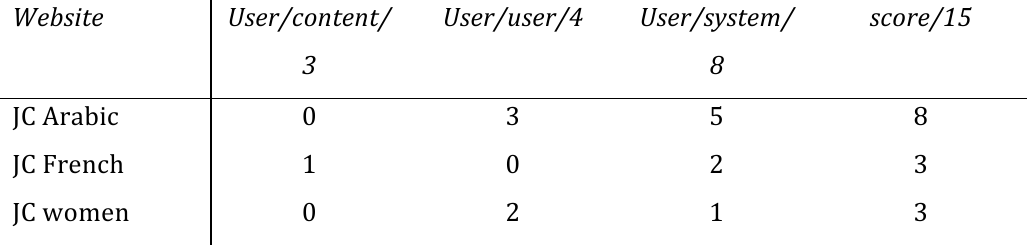
Table 4. Interactivity result